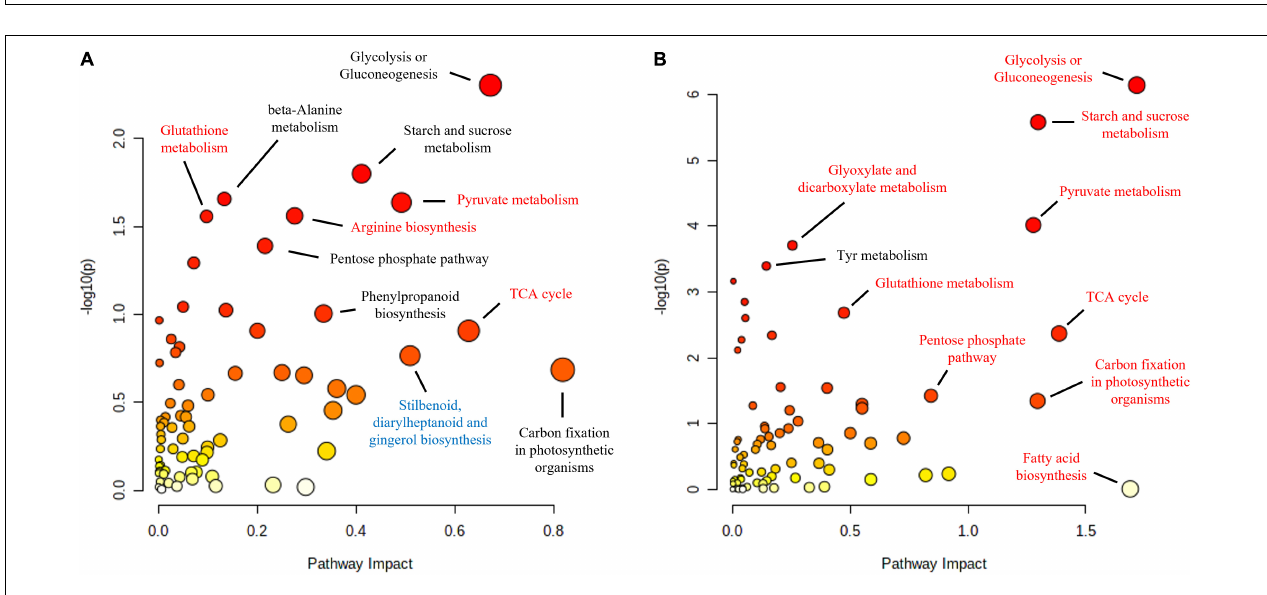
FIGURE 10 | Functional enrichment and pathway topology analysis of the metabolites and proteins affected in the roots of Q. suber (A) and Q. variabilis (B) 10 h after inoculation with P cinnamomi . Molecular pathways highlighted in red and blue contained a higher number of proteins and metabolites with increased and decreased abundance, respectively. The color of each point corresponds to its p -value (yellow to red) and its size is calculated based on the pathway impact values.